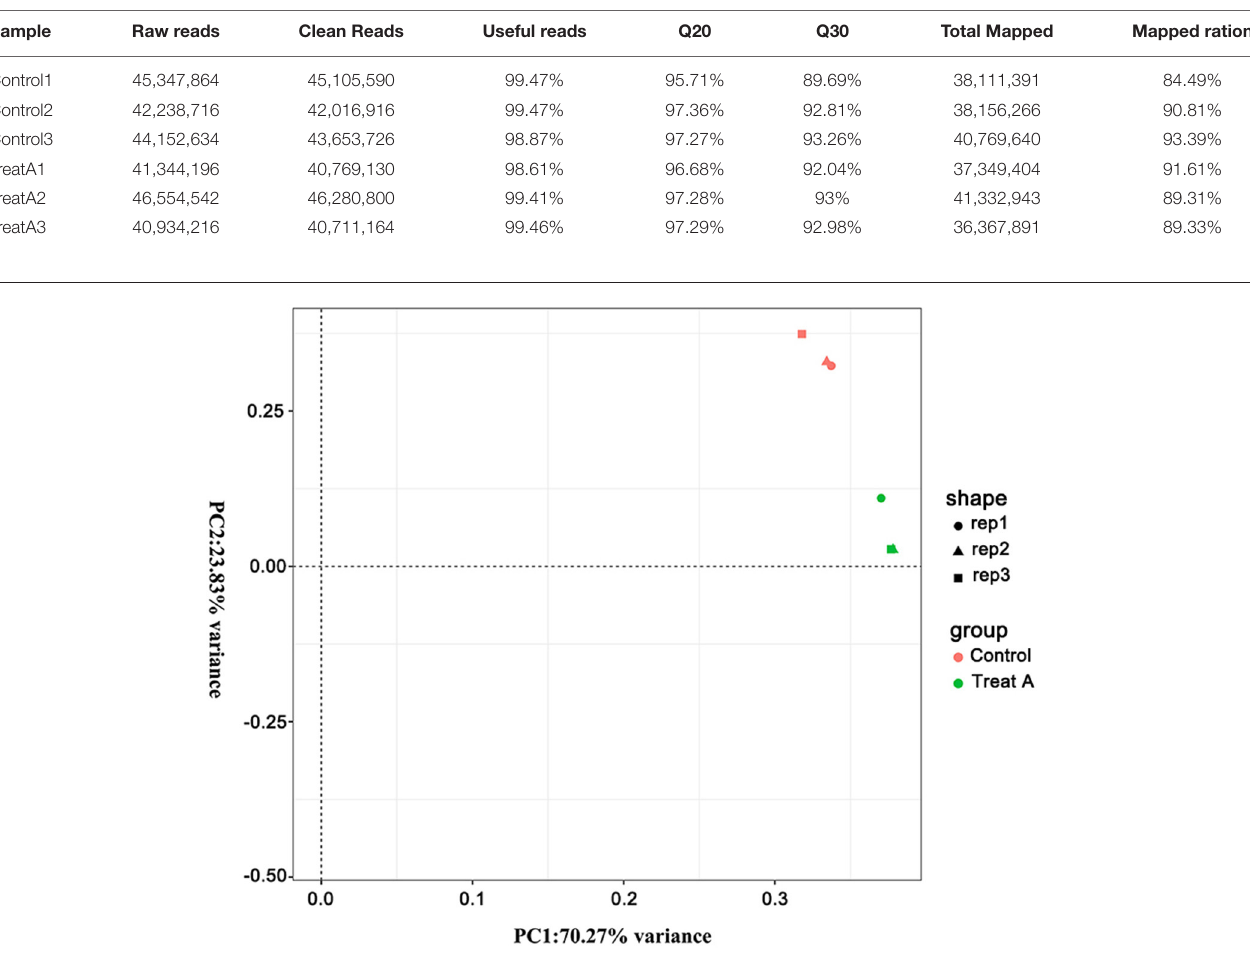
FIGURE 1 | The PCA analysis of all samples. Different shapes represent different samples, different colors represent different groups.